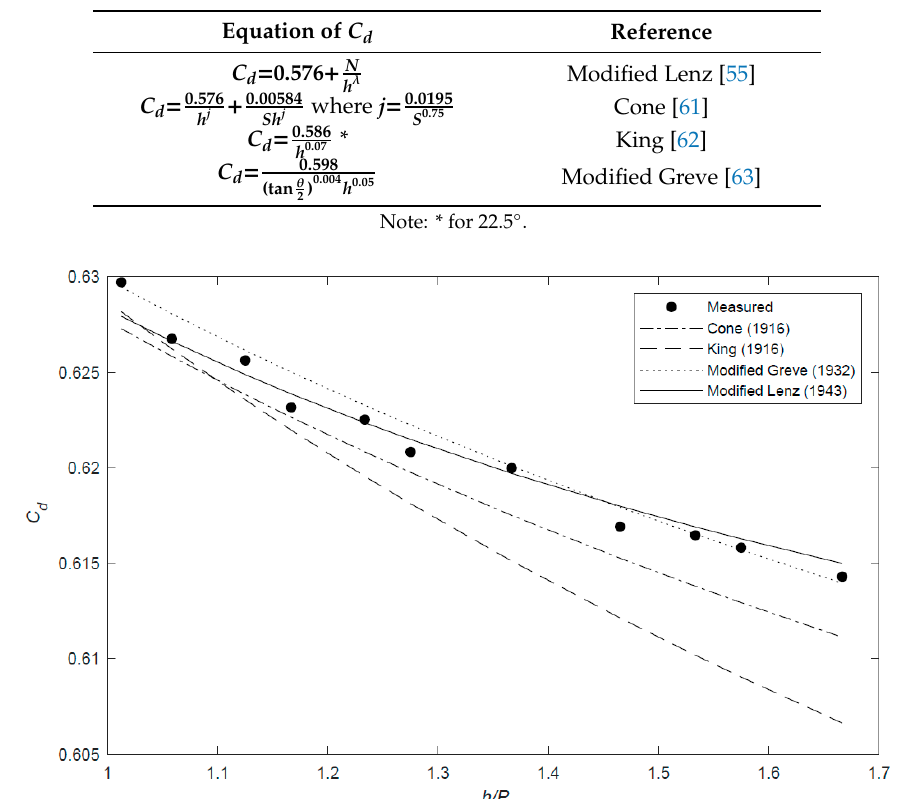
Figure 7. Discharge coefficient ( C d ) plotted against the ratio h/P for the data measured and literature formulas for free flow.